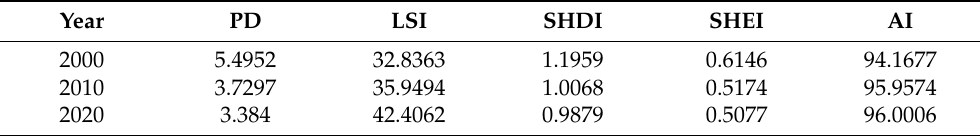
Table 15. Land-use landscape level index for urban fringe areas in Wuhan,